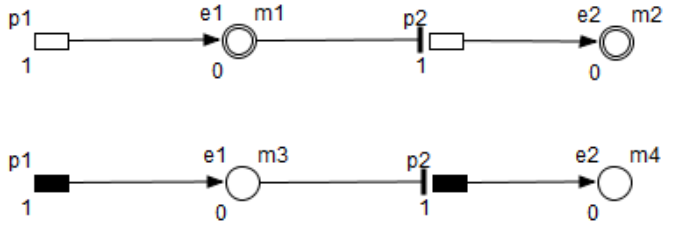
Figure 6. Inhibitory connector used to inhibit some